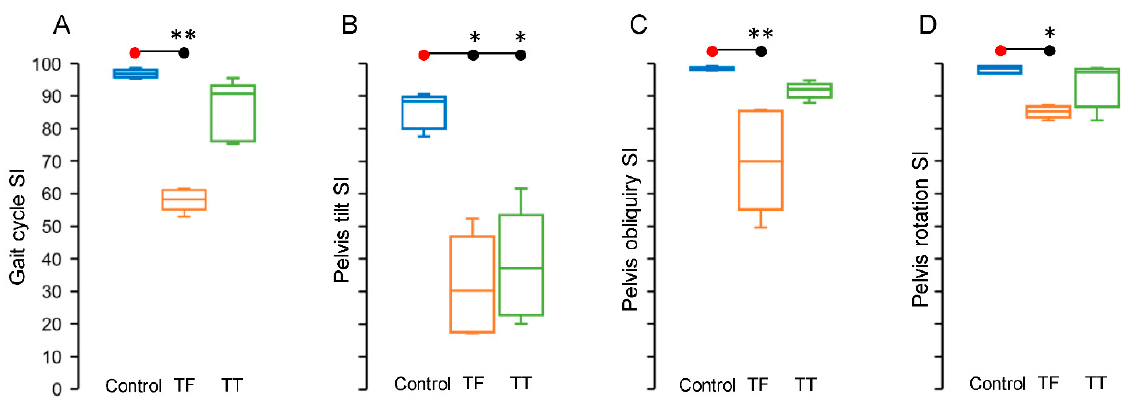
Figure 4. Box and whisker plots reporting the median value (horizontal line within the box) and the variability as interquartile range (vertical length of the box) and as the highest and the lowest values (lines above and below the box) of symmetry indexes of gait cycle ( A ), pelvis tilt ( B ), pelvis obliquity ( C ), and pelvis rotation ( D ), for each group. In all subplots, the horizontal lines with asterisks indicate statistically significant differences (* p < 0.05; ** p < 0.01). Abbreviations and symbols: SI = symmetry index; TF = transfemoral group (orange boxes); TT = transtibial group (green boxes).